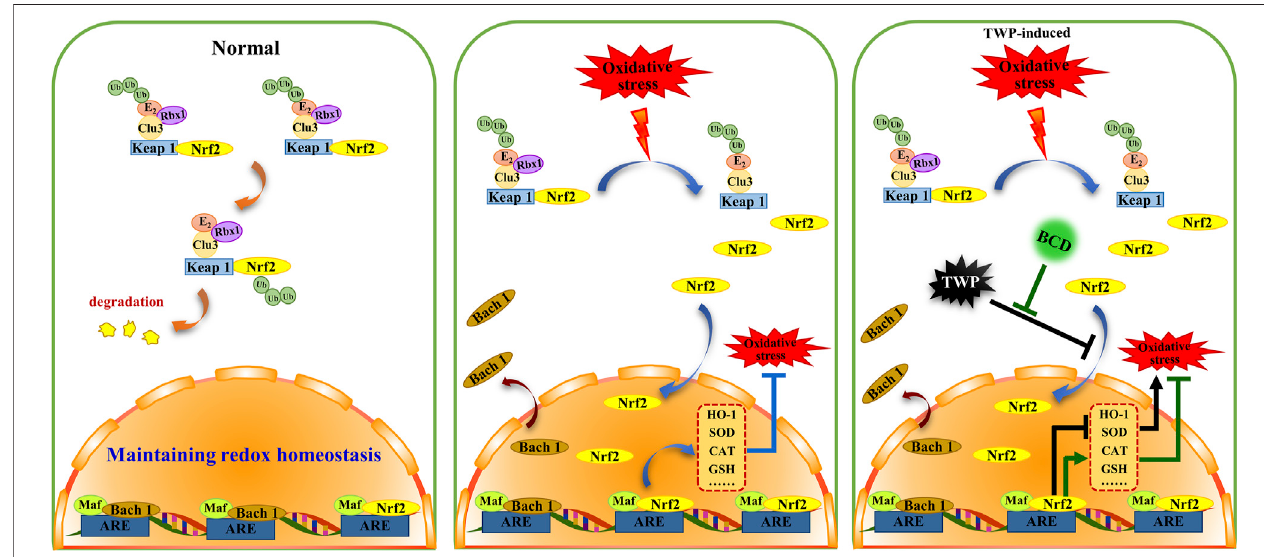
FIGURE9| TheproposedschemaforBCDfunctioninoxidativestressofTWP-inducedPOI.BCDpreventsTWP-inducedoxidativestressthroughregulatingNrf2/ Keap 1 signaling pathway. In normal circumstances, Nrf2 is predominantly distributed in the cytoplasm, where it incorporated into a complex that binds to Keap 1 and Clu3, and then to be degradation (orange indicator). While, Bach 1 is mainly distributed in nucleus. When oxidative stress occurs, Nrf2 releases from Nrf2-Keap1-Cul3 complex, then translocates into the nucleus to combined with Maf-ARE, and subsequently promotes expressions of antioxidant enzymes, that included HO-1, SOD,CAT(blueindicator).ExposuretoTWPinducesovarianoxidativestress,furthermore,TWPblocksnucleartranslocationofNrf2andBach1whichultimatelyinhibits the expression of antioxidant enzymes resulting in aggravation of oxidative damage (black indicator). However, with BCD co-treatment, the blocking of Nrf2 and Bach 1 nuclear translocation were reversed and the expression of antioxidant enzymes were increased (green indicator).